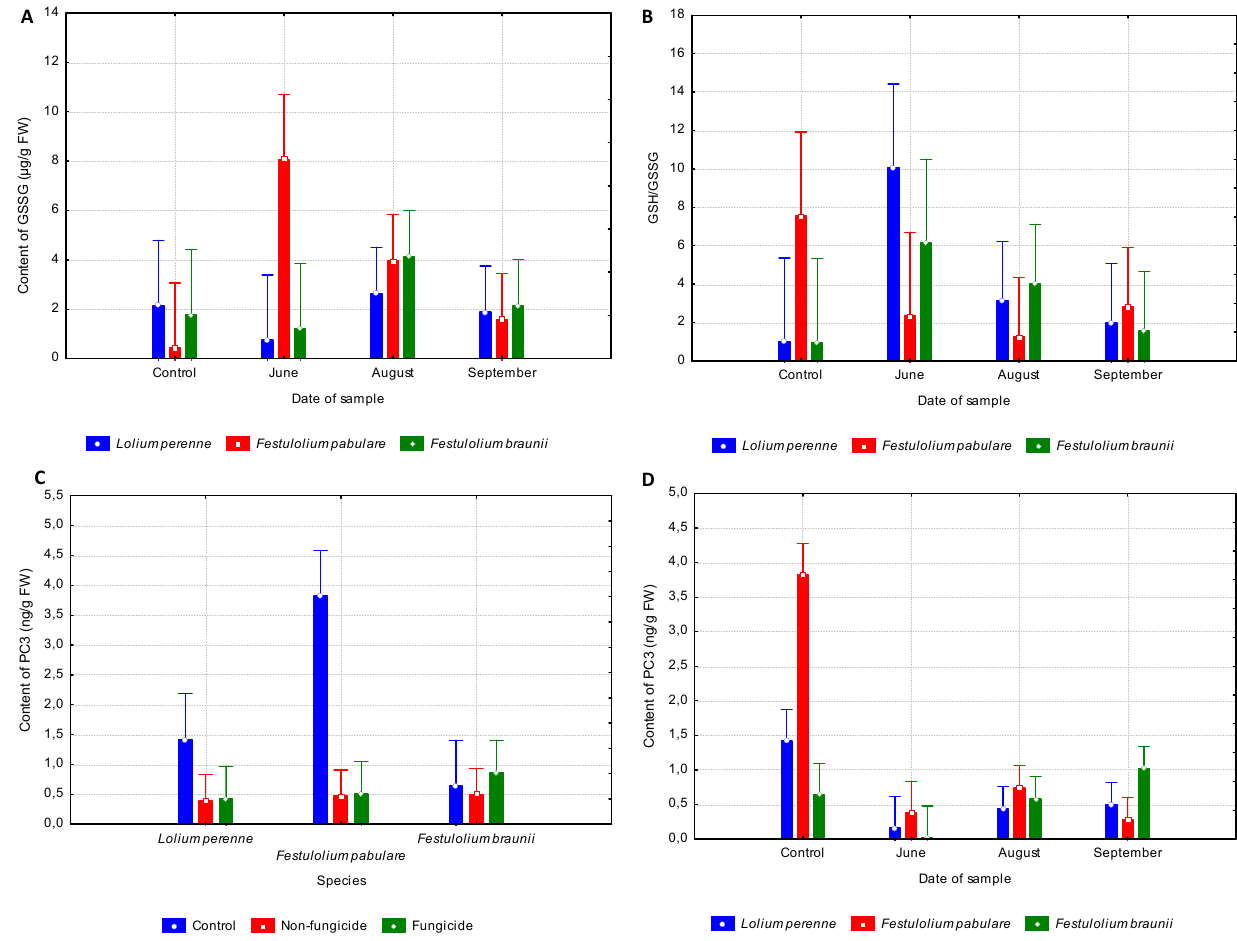
Figure 3. ( A ) GSSG content in relation to Date of sample and Species. ( B ) GSH/GSSG ratio in relation to Date of sample and Species. ( C ) PC3 content in relation to Species and Treatment. ( D ) PC3 content in relation to Date of sample and